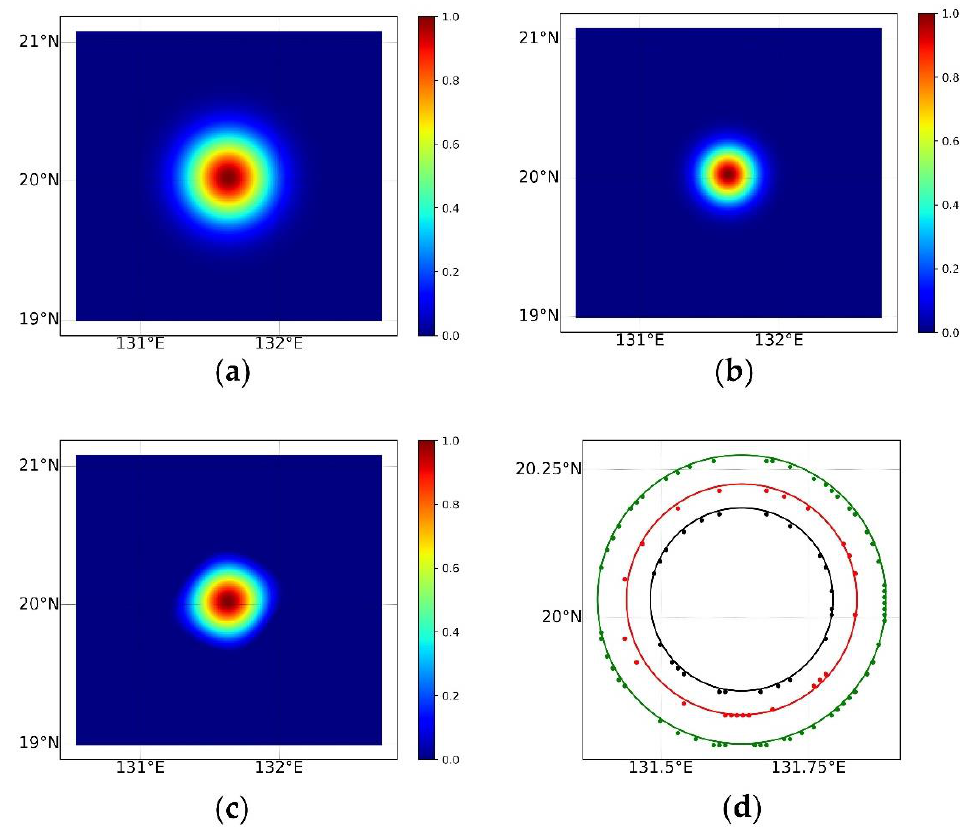
Figure 4. AGFs and half-power curves of sub-satellite point; ( a ) AGF of 5.2 ◦ ; ( b ) AGF of 3.3 ◦ ; ( c ) AGF resampled by BGI; ( d ) half-power points and half-power curves obtained from an AGF of 5.2 ◦ (green), an AGF of 3.3 ◦ (black), and an AGF resampled by BGI (red). Note that AGF is